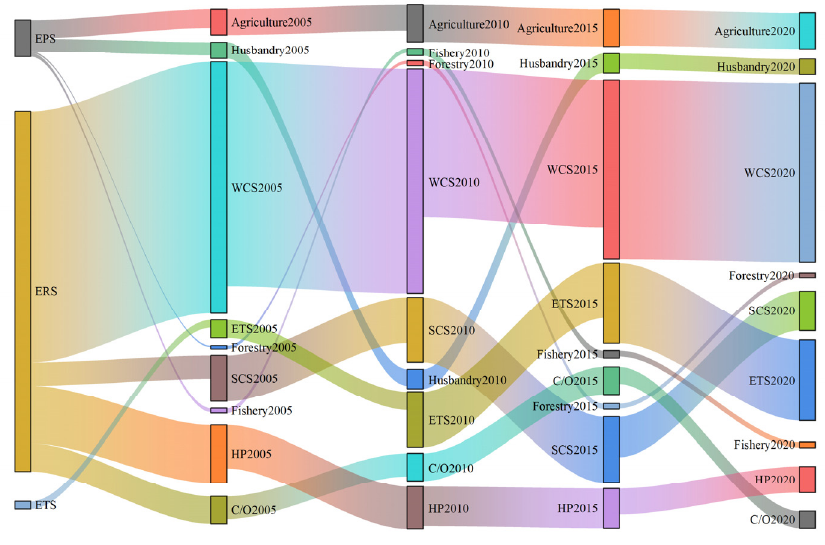
Figure 6. Cumulative change rate (%) of sub-indicators from 2005 to 2020.